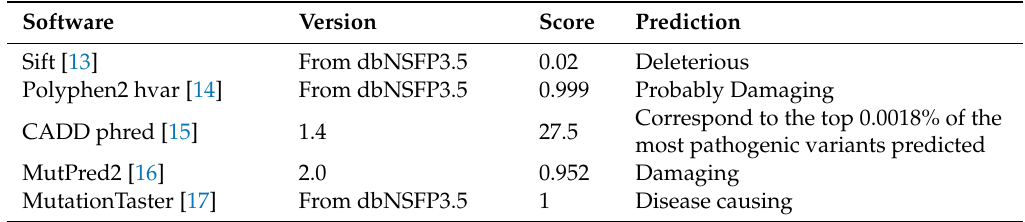
Table 2. List of pathogenicity predictions from di ff erent software programs and their relative scores for the pathogenic variant, c.197 G > A, on the FOLR1